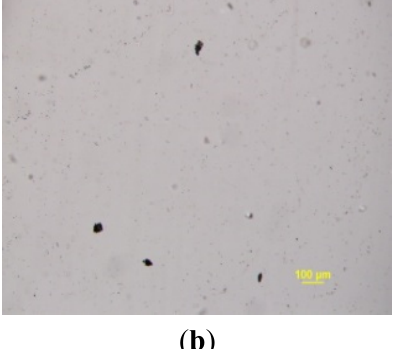
Figure 2. Schematic of the experimental setup ( a ) (1 - the inner cylinder, 2 - the outer cylinder, 3 - a speed reduction box, 4 - speed-adjusting motor, 5 - a speed controller, 6 - ADV, 7 - a transfer pipette, 8 - a volumetric flask, 9 - a dropper, 10 - a slide glass with a cover glass, 11 - a biological fluorescence microscope connected to a high resolution CCD, and 12-an image processing system in the computer), and a representative example image ( b ) including four typical flocs, formed for G = 5.36 s − 1 and ϕ = 7.87 × 10 − 5 at a experimental time of 360 min without electrolyte added into the suspension.